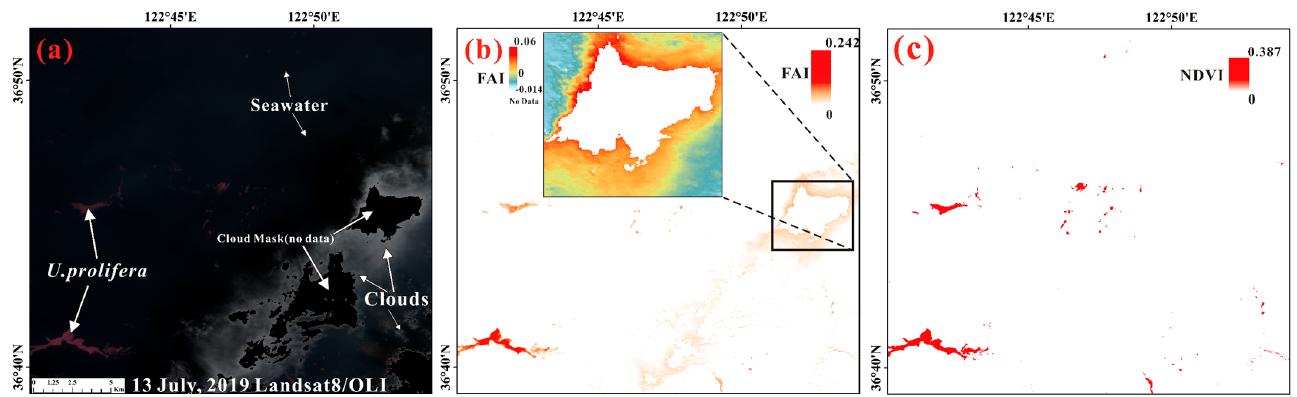
Figure 16. Schematic diagram of the model. ( a ) Landsat8/OLI pseudo-true-color image on 13 July 2019, R:G:B = band 5:4:3, ( b ) the result of FAI value greater than 0 on 13 July 2019, and the black box is the result of FAI value in cloud area, ( c ) the result of NDVI value greater than 0 on 13 July 2019.